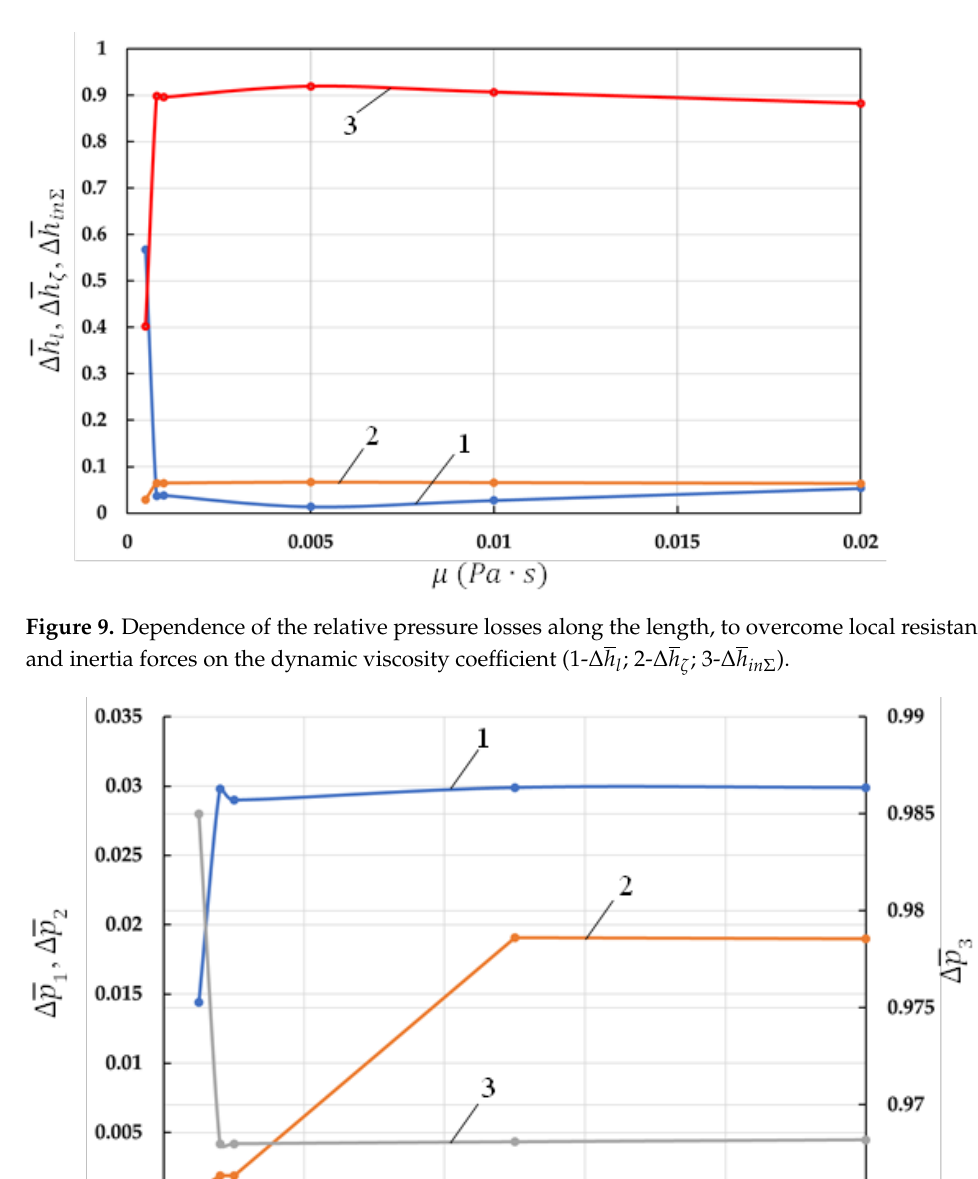
; ∆ p ; ∆ p , on the dynamic viscosity coefficient ; 𝛥𝑝 ; 𝛥𝑝 , on the dynamic viscosity coeffi- 1 2 3 1 2 3